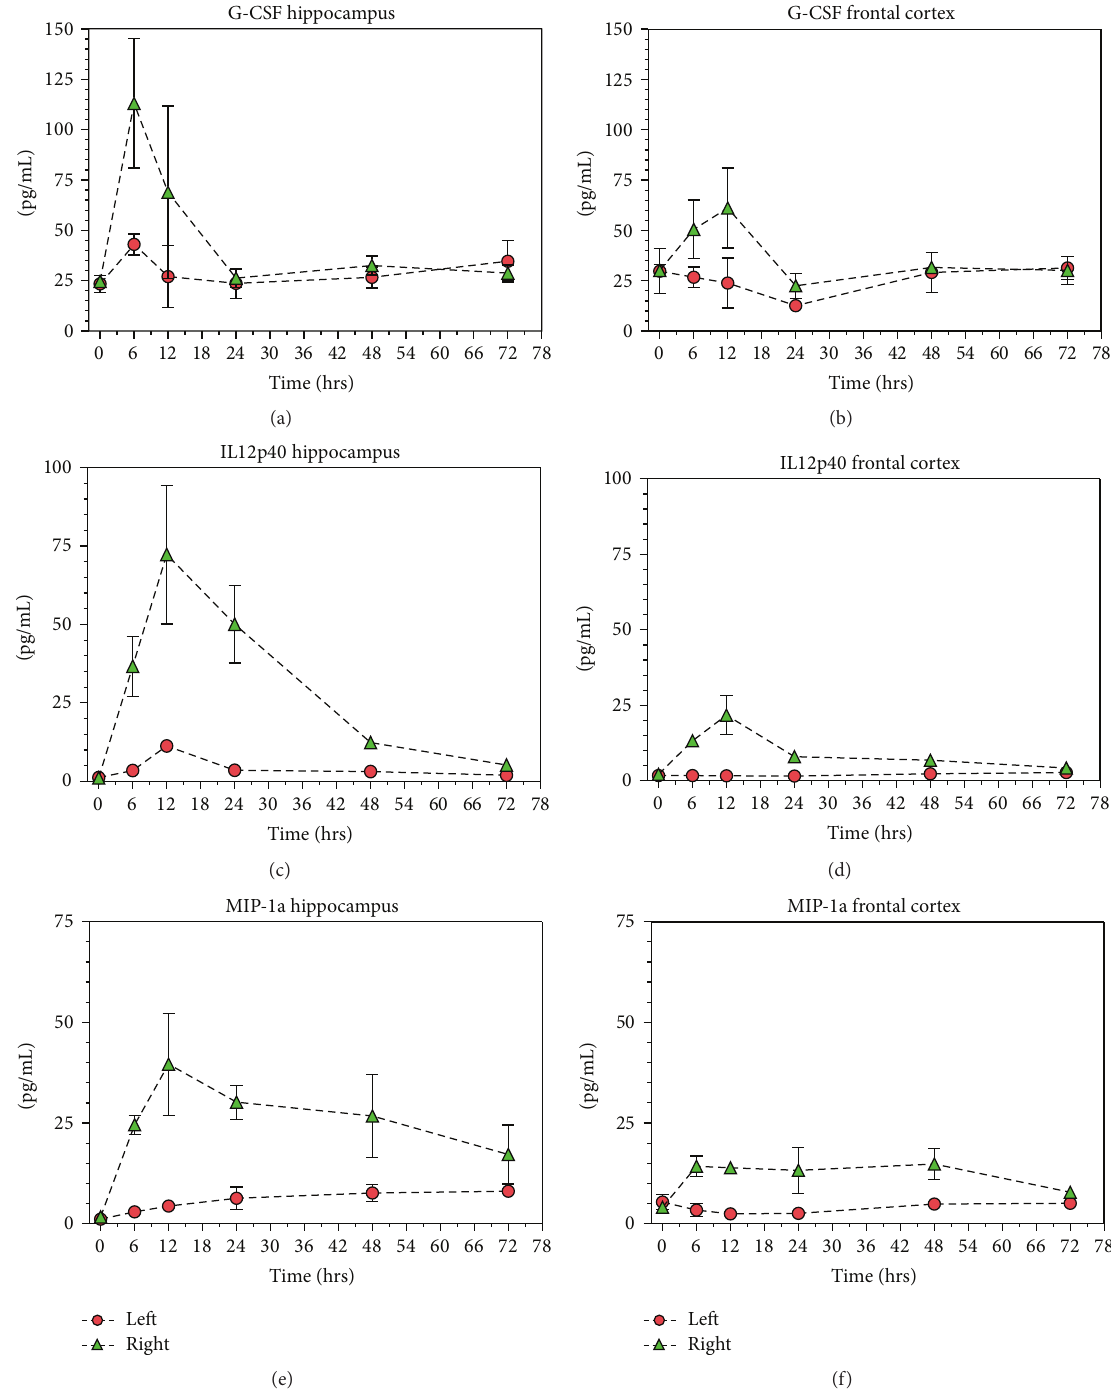
Figure 7: Three of the 17 cytokines measured in hippocampus and frontal cortex (path of the needle track) were significantly changed on the lesioned side compared to the control side. Each time point was determined from 𝑛 = 3 mice (total of 18 pairs of hippocampi), and assays were run in triplicate. 2-way ANOVA (treatment versus time) revealed a significant effect ( 𝑃 < 0.05 ) for each of the cytokines except for G-CSF levels in frontal